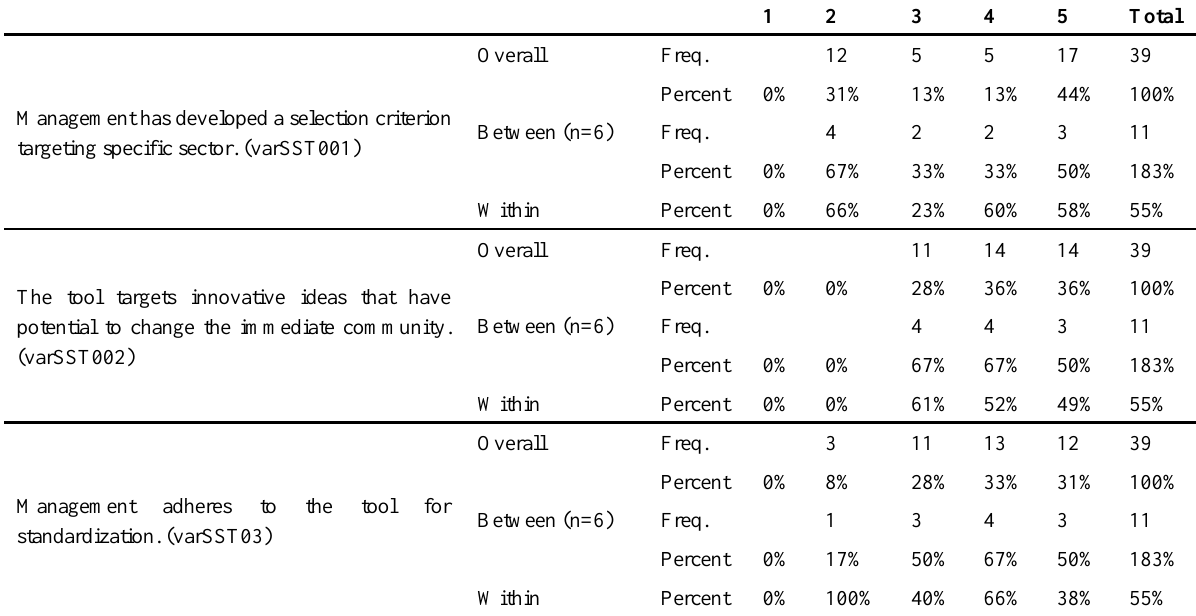
Table 4: Standard Selection